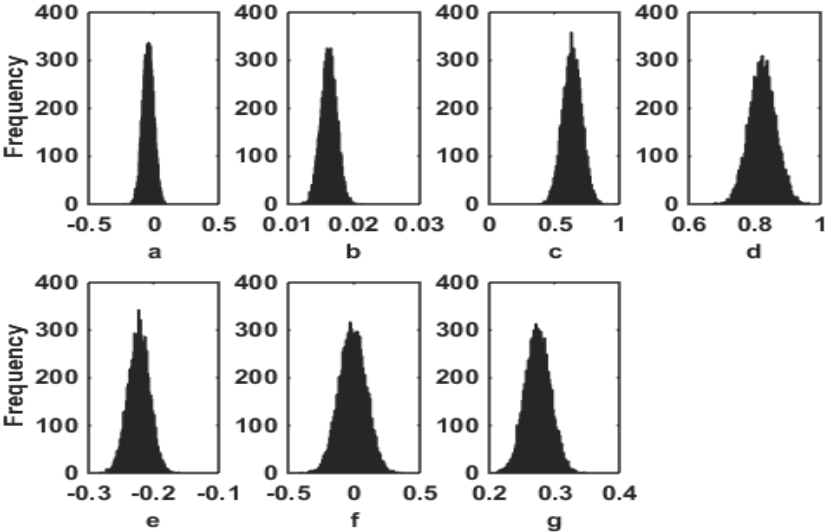
Figure 8. Figure 7 Histograms of the BLR parameters of PC2 that map all uncertainty onto the parameter Figure 8. Figure 7Histograms of the BLR parameters of PC2 that map all uncertainty onto the space (( a – g ) refer to each regression coe ffi parameter space ( a – g refer to each regression coefficient).